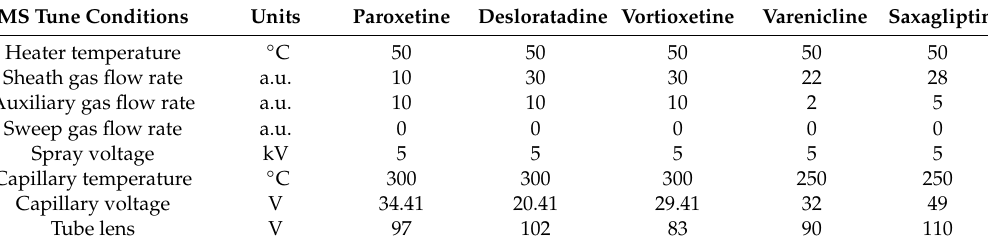
Table 2. ( + )ESI-MS conditions optimized for individual drug